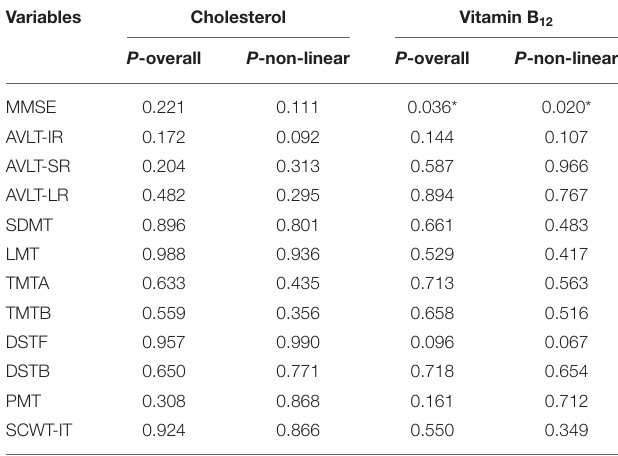
TABLE 4 | Dose-response relationship between cholesterol or vitamin B 12 and multi-domain cognitive function.